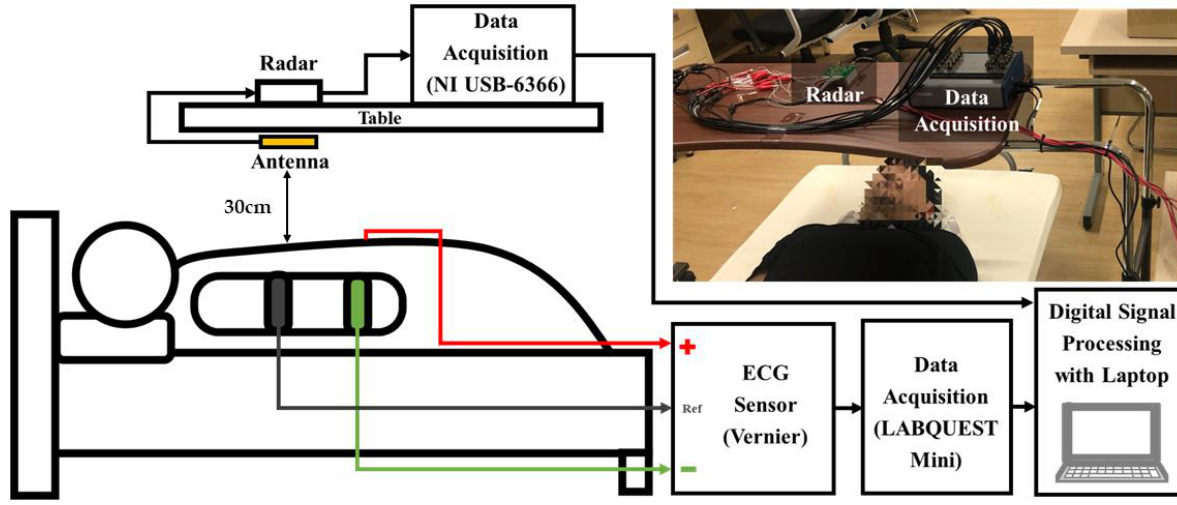
Figure 3. Block diagram of the experimental setup for vital signal detection using the 5.8 GHz CW radar.